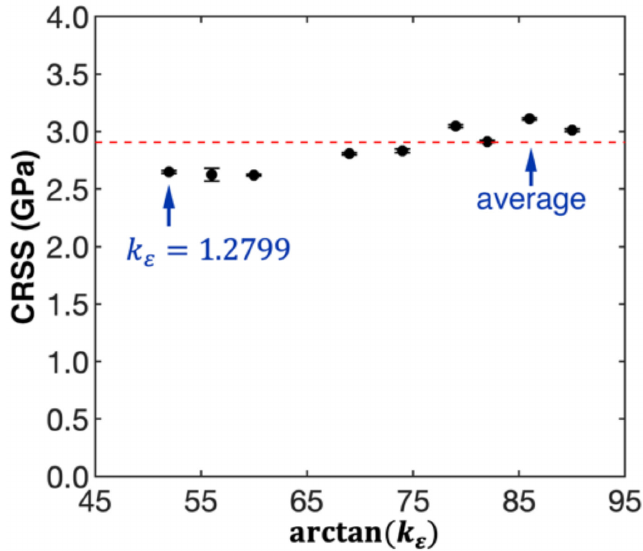
Figure 3. Variation of the critical resolved shear stress (CRSS) when the torsion/tension strain ratio changes ( k ε ≥